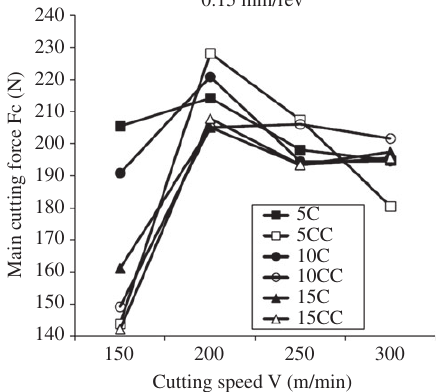
Figure 7 Changes in Fc values in 5%, 10% and 15% MgO reinforced MMC specimens by cutting speed (C and CC cutting tools; 0.15 mm/rpm feed